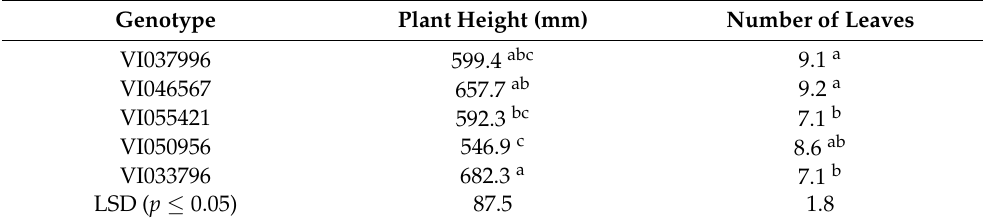
Table 3. Effect of genotype on Abelmoschus esculentus plant height and number of leaves. In each column, values followed by different letters indicate statistically significant ( p ≤ 0.05)